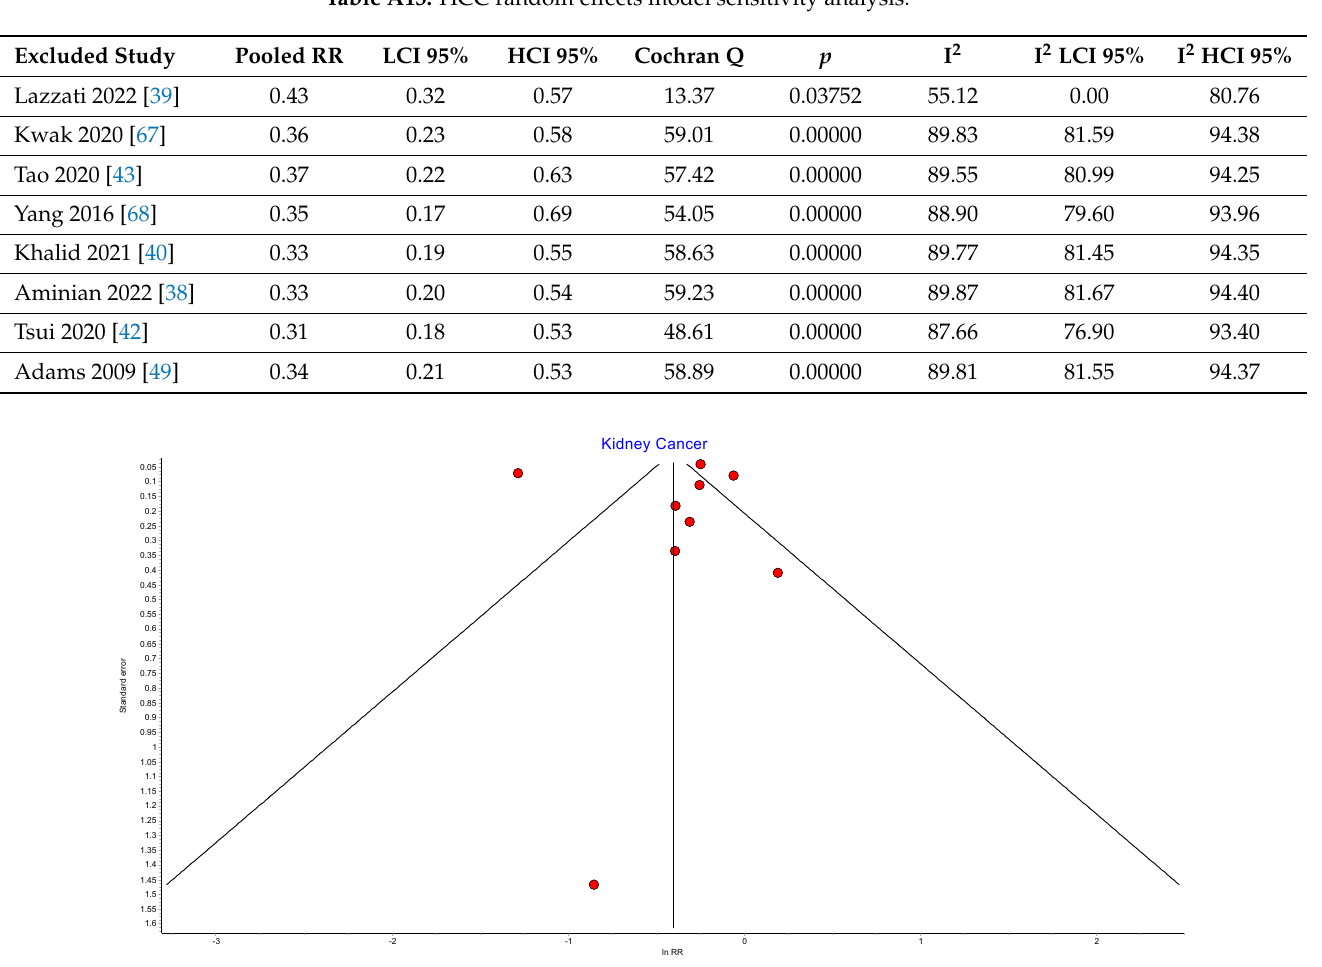
Figure A14. Kidney cancer random effects model funnel plot. Table A14. Kidney cancer random effects model sensitivity analysis.